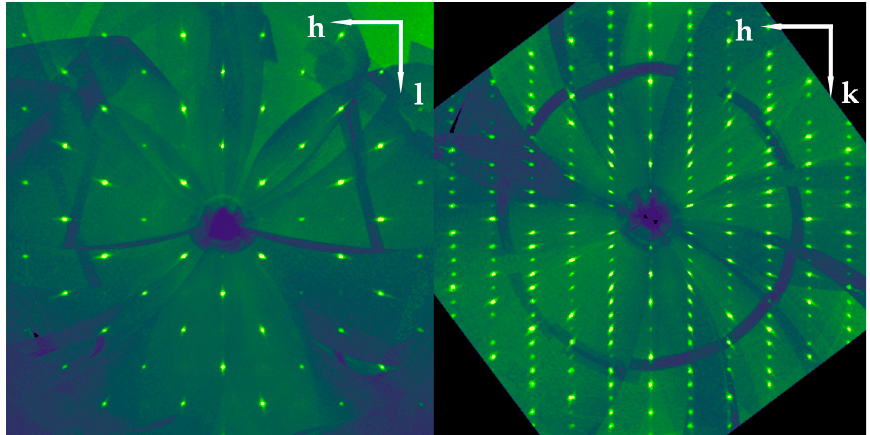
Figure 8. Reconstructed reciprocal diffraction images of Tl[CB 11 H 12 ], indicating no further h values that would lead to an ordering of the carbon-atom sites in the crystal structure of Tl[CB 11 H 12 ].